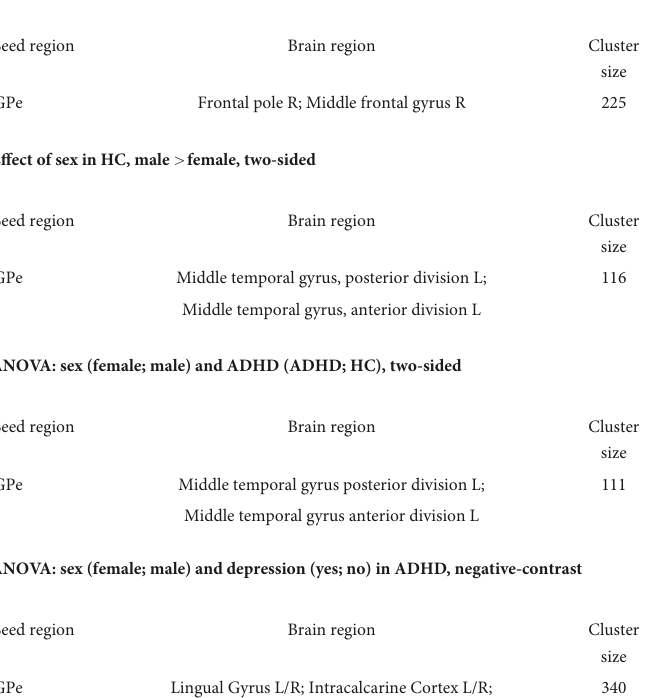
TABLE 2 Significant clusters from the seed-region mask of the GPe. Effect of sex in ADHD, female > male,